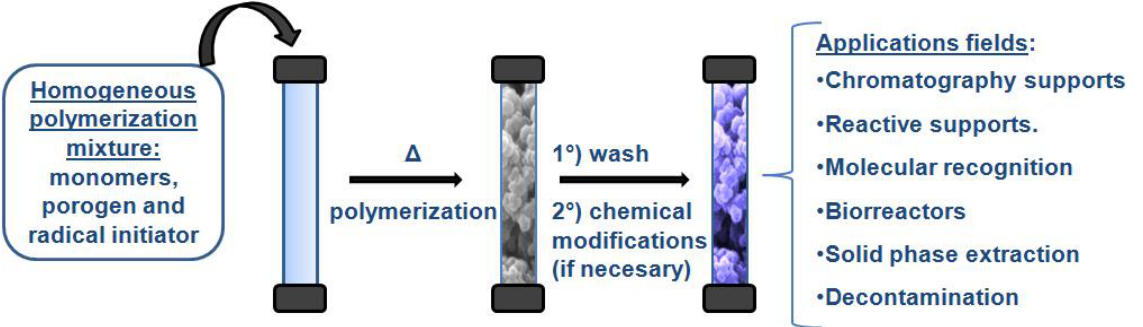
Figure 2. Different steps for the preparation of continuous polymer